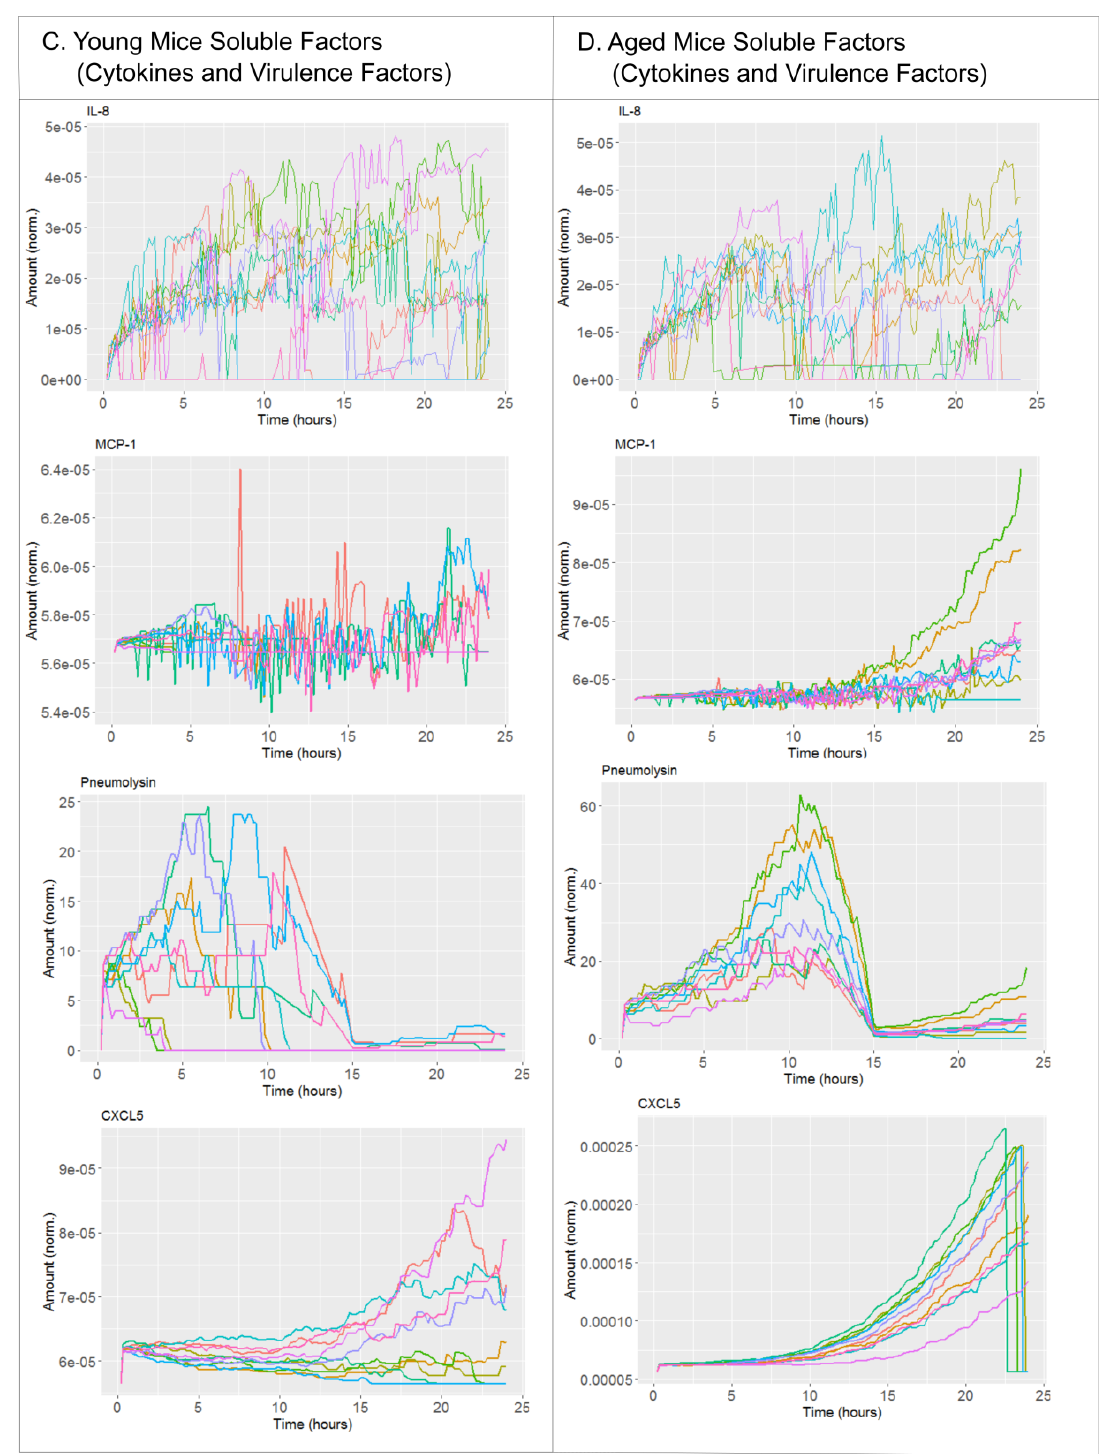
Figure 1. Simulation of the nominal solution. ( A ). Cellular components of the nominal solution of the model (young mice). ( B ). Cytokines and virulence factors of the nominal solution of the model (young mice). ( C ). Cellular components of the simulations of aged mice. ( D ). Cytokines and virulence factors of the simulations of aged mice. We display 10 simulations for the parameter set of the nominal solution (Table S1). Each solution is represented by a different color.